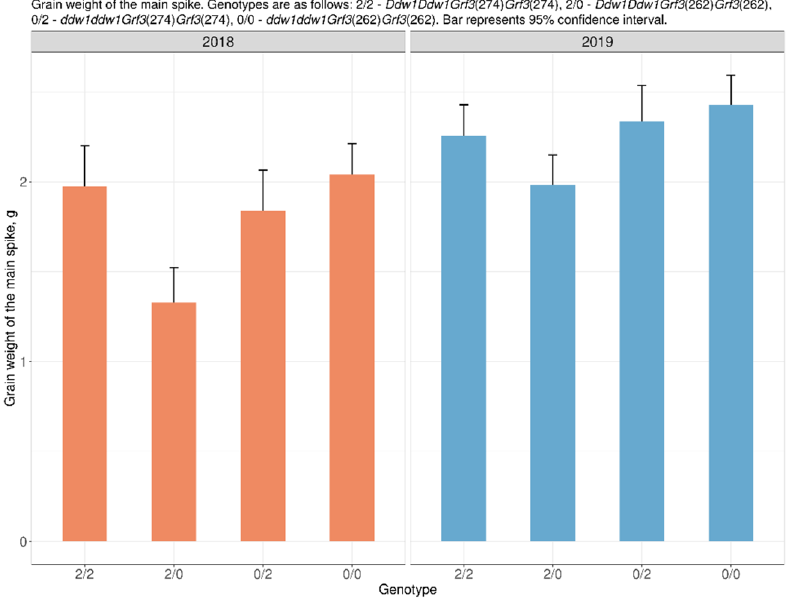
Figure 1. The effect of the allelic state of DDW1 and Grf3 on grain weight of the main spike. The thousand grain weight in spring triticale plants with the dwarfing Ddw1 and Grf3 (274) alleles was statistically significantly higher by 5.94 g (16%) compared to that in semi-dwarf plants with the Ddw1 / Grf3 (262) combination in F 4:5 (2018). In F 5:6 (2019), the difference between the same combinations of alleles was 2.96 g (6%), but no statistical significance was found. In tall plants of spring triticale (without Ddw1 ) in F 4:5 (2018) and F 5:6 (2019), no statistically significant difference in thousand grain weight between different allelic variants of the Grf3 gene was found. The number of grains per main spike did not show statistically significant differences between the combinations of genes in both years of the study, although certain trends were observed (Table S1, Figure 2).